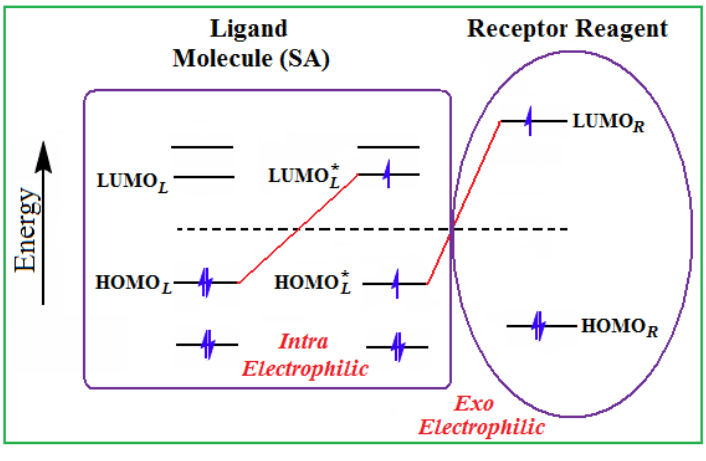
Figure 3. The electrophilic docking structure-reactivity algorithm correlating electronegativity and chemical hardness with chemical carcinogenesis. The algorithm starts with electronegativity docking (equalization) between the ligand and the receptor (the middle dashed line). Next, intra-molecular (in connection with specific structural